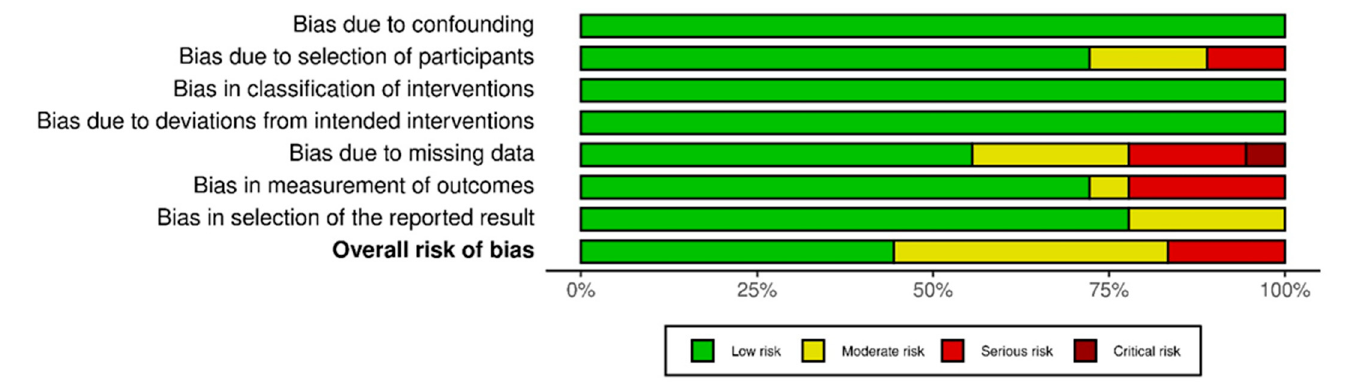
Figure 3. Overall presentation of risk of bias of the studies included.